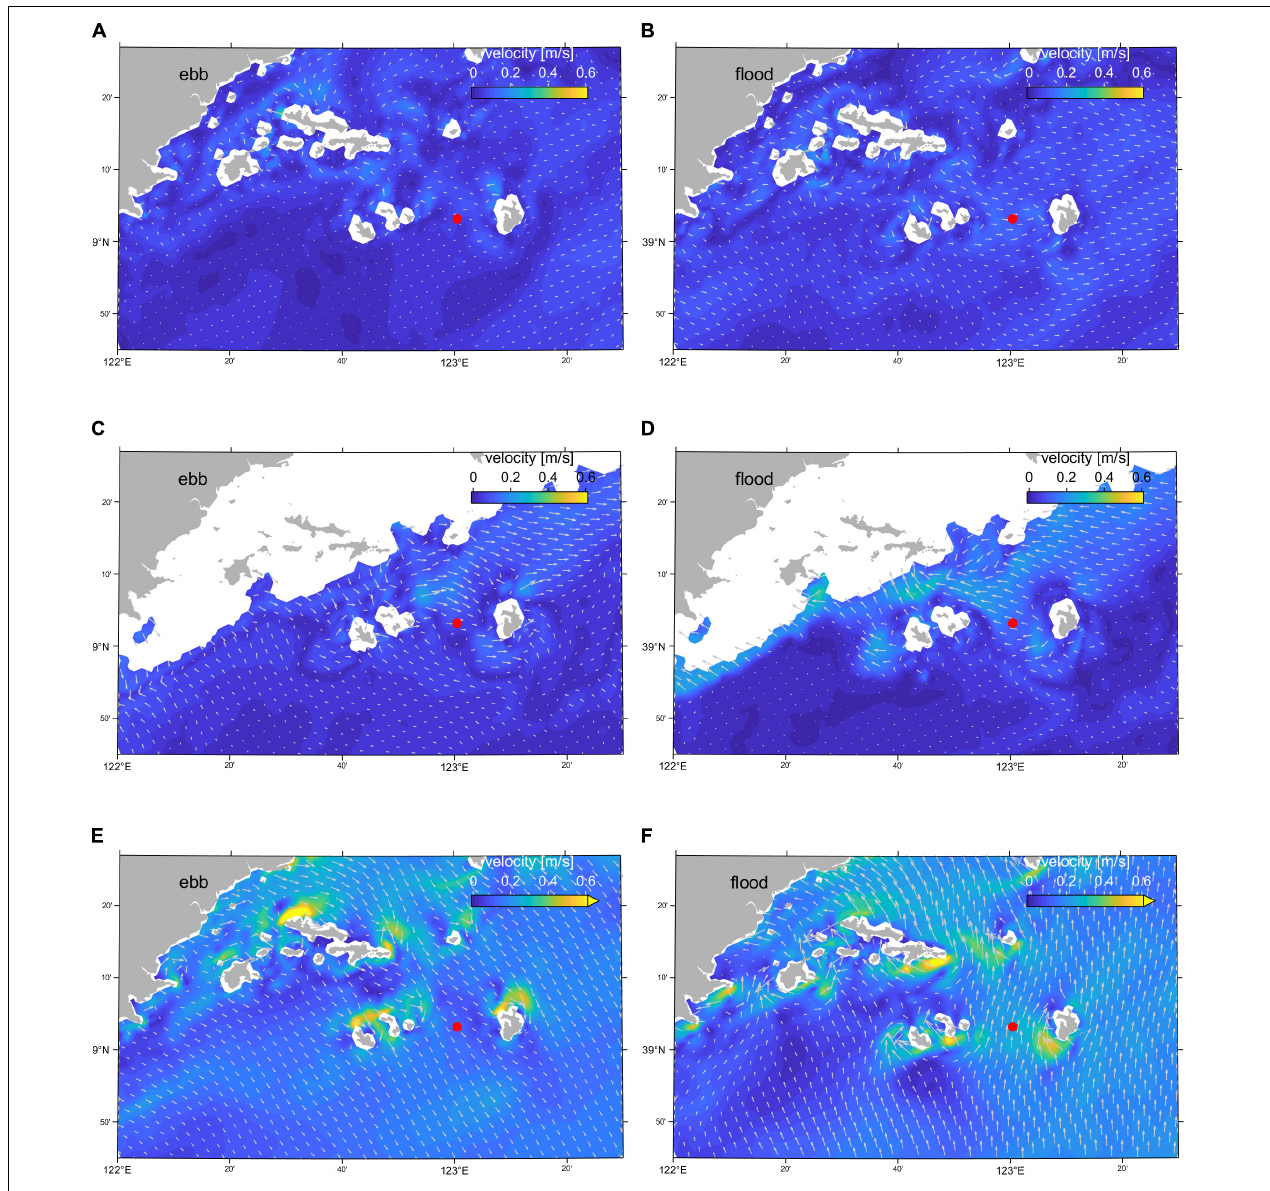
FIGURE 8 | Modeled M 2 baroclinic flow for horizontal current fields (m/s) 6-h apart (at ebb tide and flood tide) at different depths. (A,B) Baroclinic current at 15 m depth. (C,D) Baroclinic current at 30 m depth. (E,F) Barotropic flow. The baroclinic current component will add (or subtract) to the total current. The ADCP mooring location is marked as a red dot.